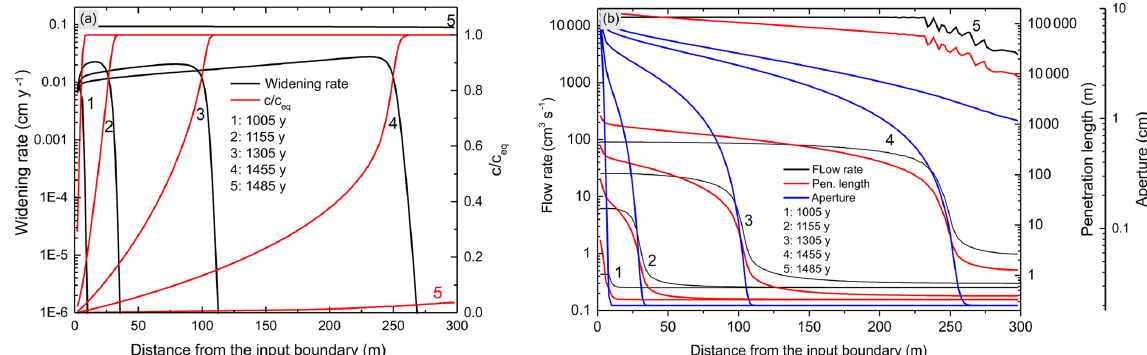
Figure 21. Profiles of different parameters at given times for the single-seeded case (network evolution presented in Fig. 5). (a) Widening rates (black lines, cmyr − 1 ) and saturation ratio (red lines, c / c eq ) ; (b) flow rates (black), penetration lengths (red), and aperture widths (blue).